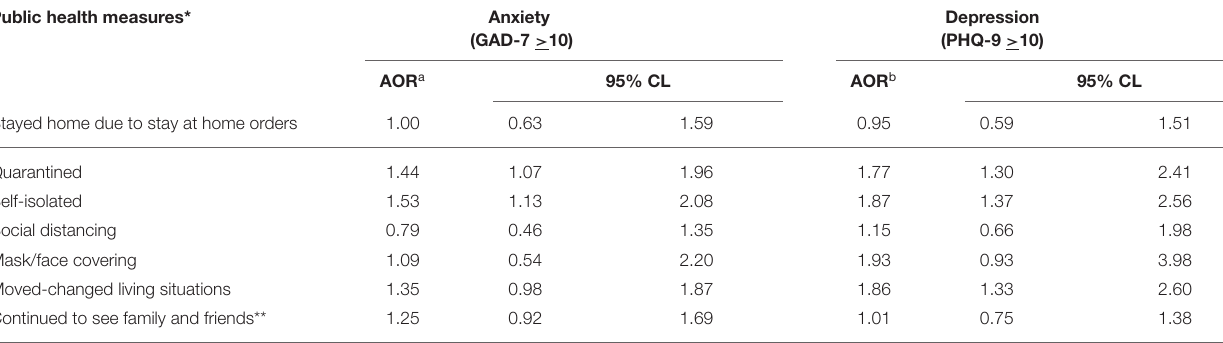
TABLE 3 | Practicing public health measures and adjusted odds of anxiety and